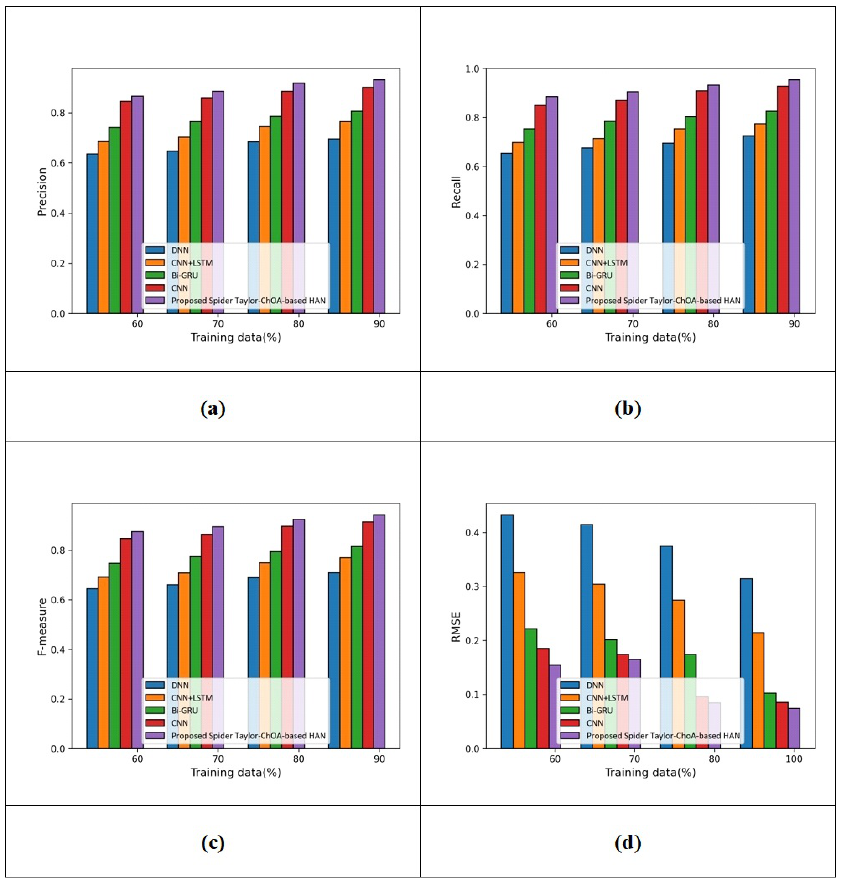
training data = 100%.